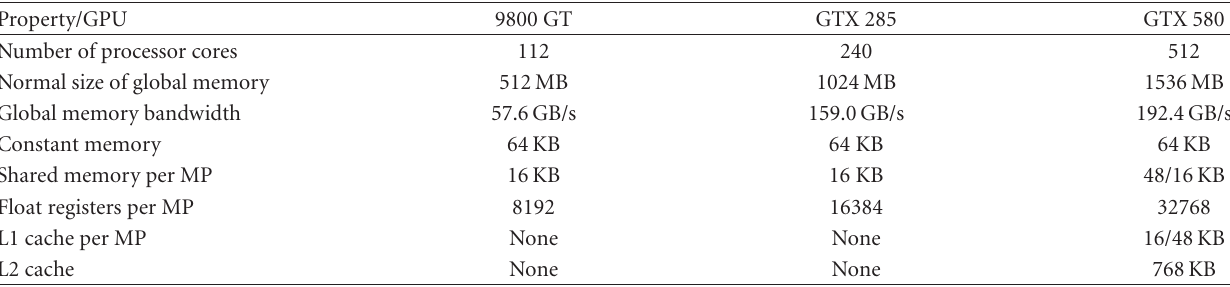
Table 1: Comparison between three Nvidia GPUs, from three di ff erent generations, in terms of processor cores, memory bandwidth, size of shared memory, cache memory, and number of registers; MP stands for multiprocessor and GB/s stands for gigabytes per second. For the GTX 580, the user can for each kernel choose to use 48KB of shared memory and 16KB of L1 cache or vice